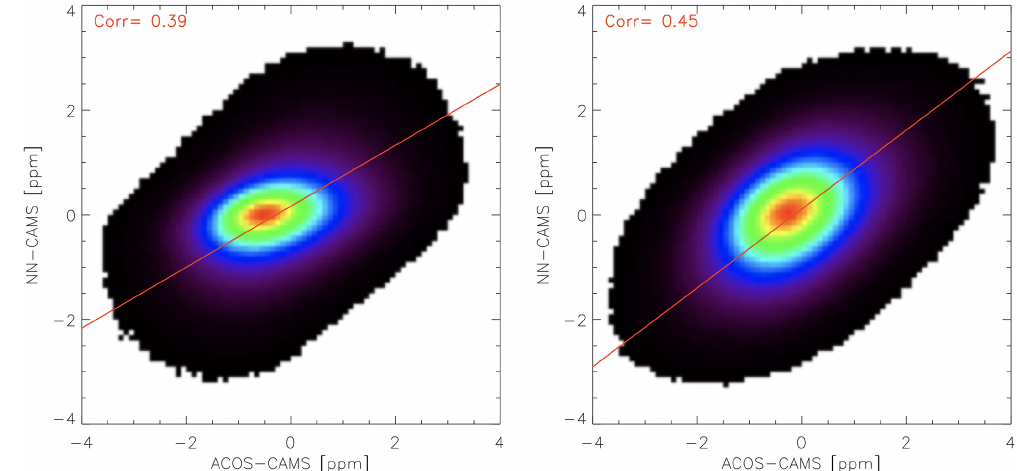
Figure 8. Density histogram of the innovation, i.e., the difference between the satellite product and the model estimates, differences between either one of the two satellite datasets and the CAMS model. The red line shows the result of a linear fit through the data points aiming at a minimization of the distance to the best line. The left figure is for the nadir dataset, whereas the right figure is for the